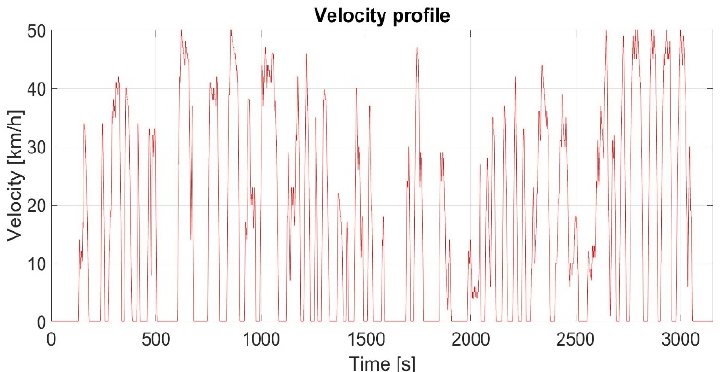
Figure 13. Tram speed profile for line No. 14.